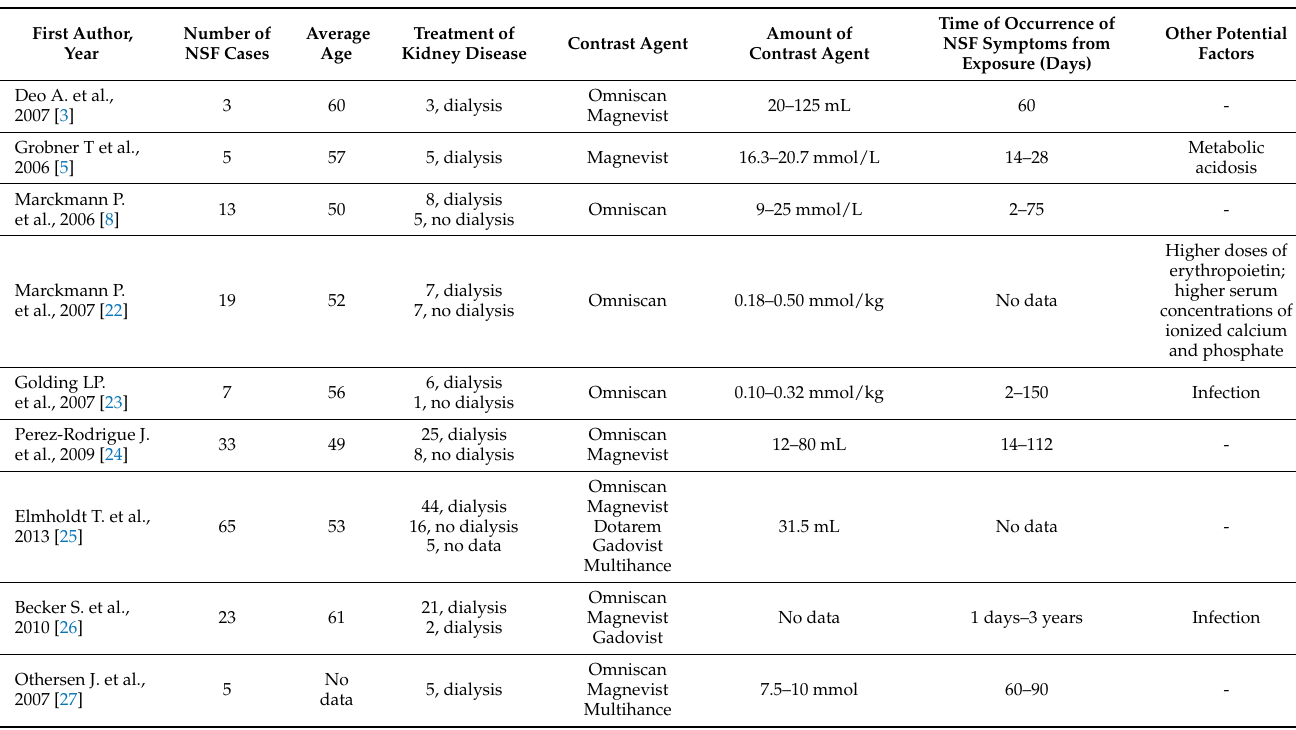
Table 5. Analysis of articles included in the review.